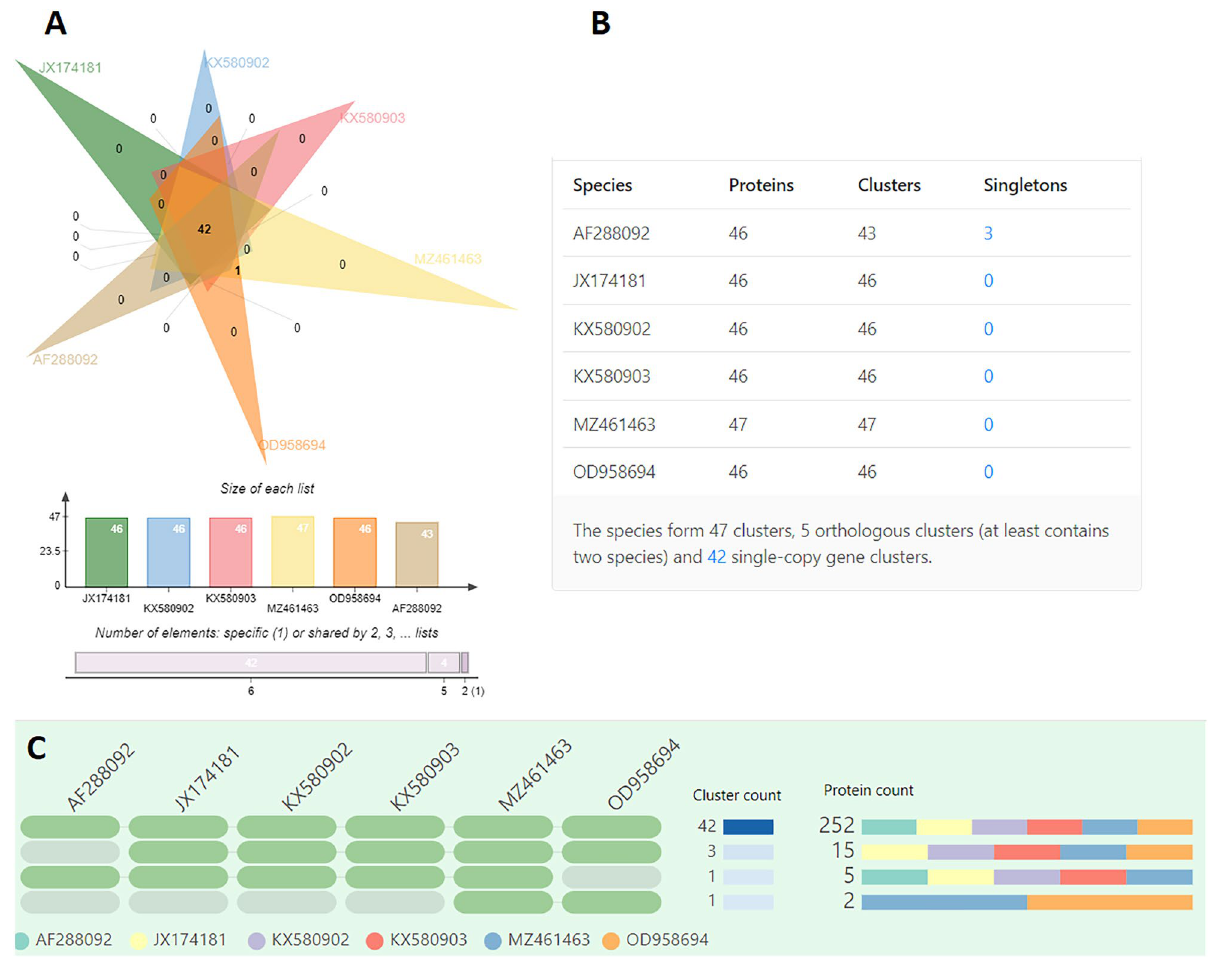
Figure 6. Venn diagram showing the distribution of orthologous gene clusters across Naegleria species and the total number of orthologous gene clusters of each organism ( A ). The orthologous cluster and singletons gene cluster ( B ). The occurrence table shows the occurrence pattern of shared orthologous groups among Naegleria species ( C ); the pattern towards the left shows the cluster count (the number of clusters shared between species) and protein count (number of protein members in the shared